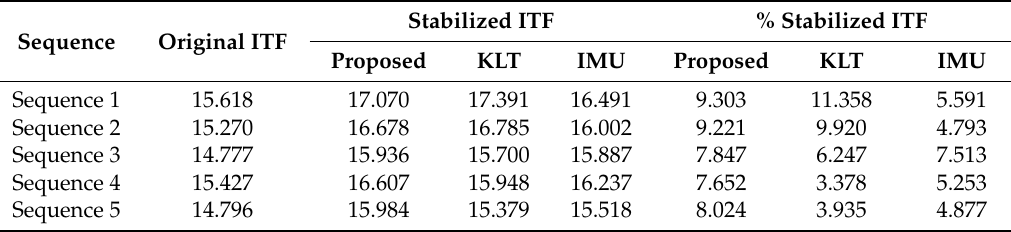
Table 3. Comparison of ITF by the different algorithm.